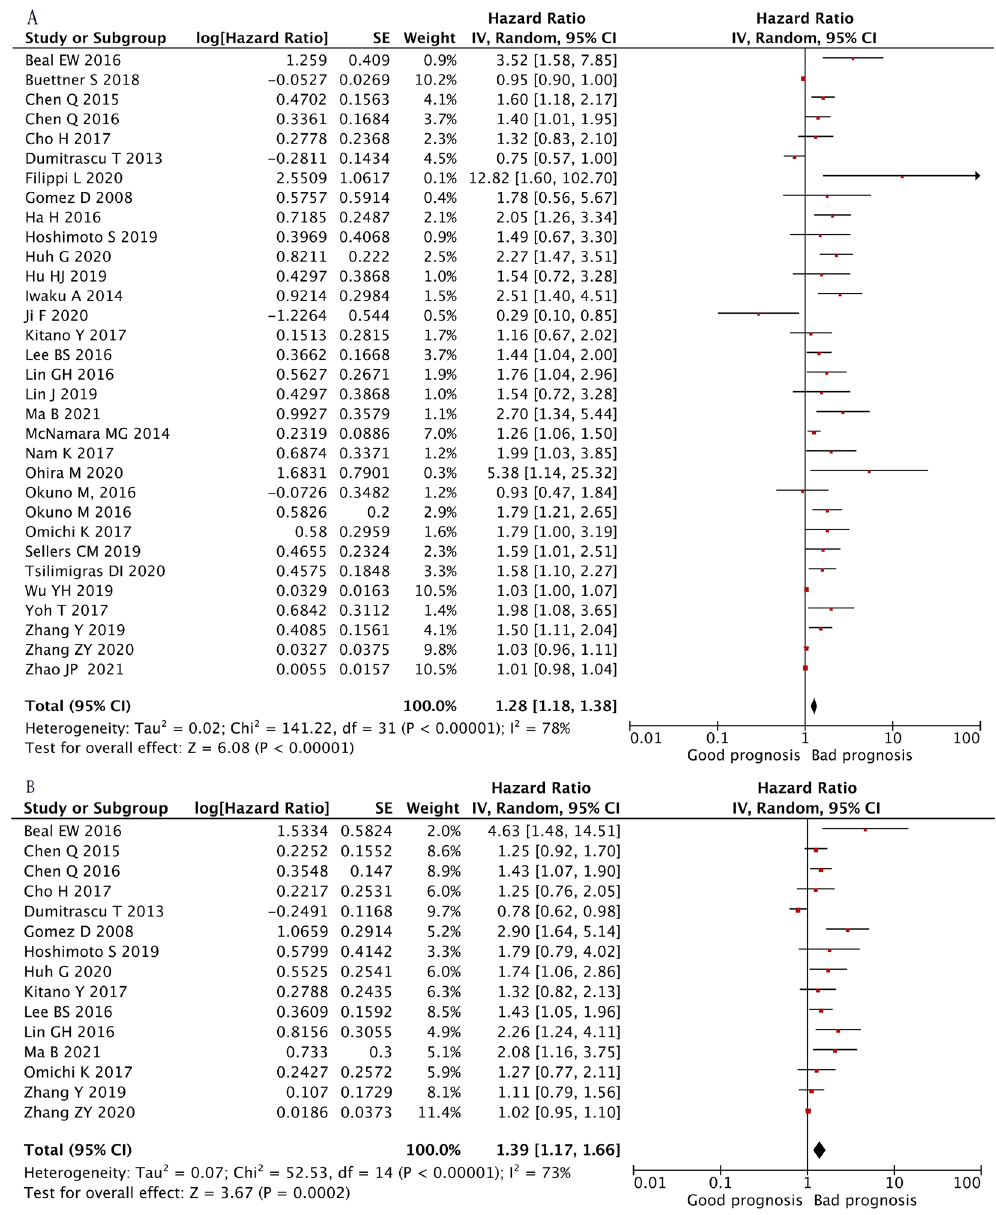
region. Although, we observed no statistical significance in DFS for Western patients, the number of included studies from Western countries was limited (n = 4) and displayed a high level of heterogeneity (I 2 = 88%, p < 0.01,